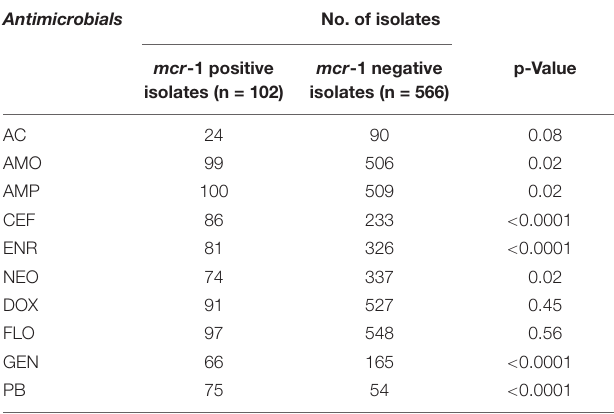
TABLE 2 | The mcr -1 positive E. coli and the mcr -1 negative E. coli isolatesfrom poultry farms.